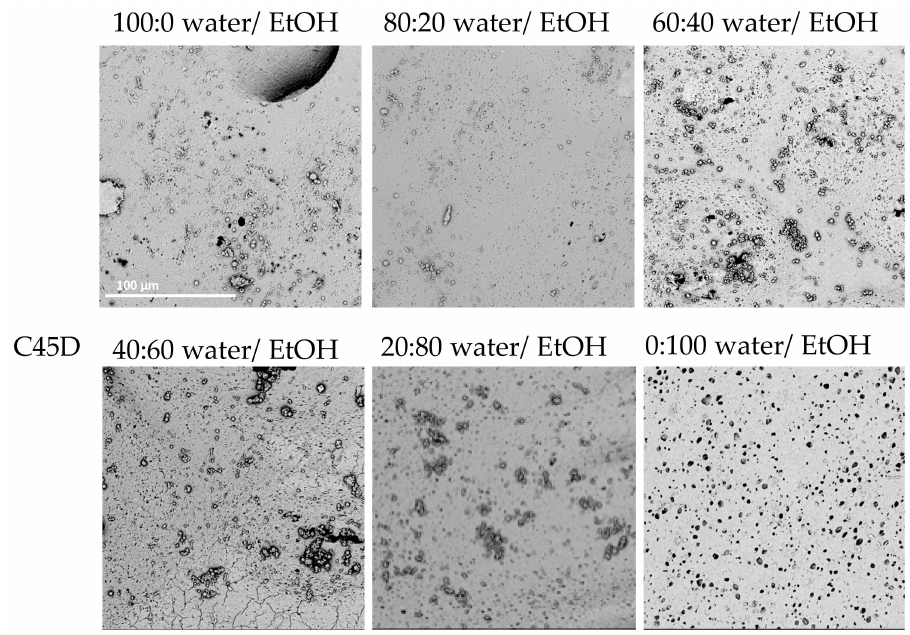
Figure 2. Morphology of internal surface of cylindrical scaffolds obtained from ChronoFlex C45D for different nonsolvent compositions; scale bar: 100 µ